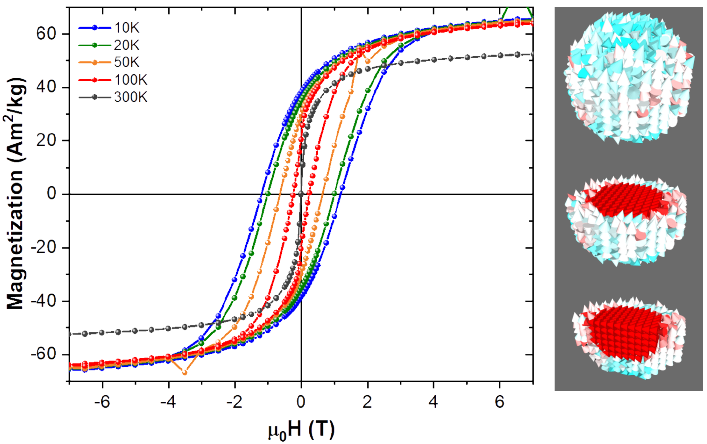
Figure 2. Experimental magnetization isotherms at different temperatures for a real sample of CoFe 2 O 4 NPs, as measured on SQUID magnetometer ( left ). A simulated internal spin structure for the model showing both the ordered core and the disordered shell is also shown ( right ). Table 1. Basic magnetic parameters of the prototype magnetic NP, determined from the ZFC-FC curves and magnetization isotherms. Coercive field at 10 K, H 10 c ; anisotropy field at 10 K H 10 ; saturation k magnetization at 10 K and 300 K, M 10 , M 300 , remnant magnetization at 10 K, M 10 r ; effective anisotropy S S constant K eff